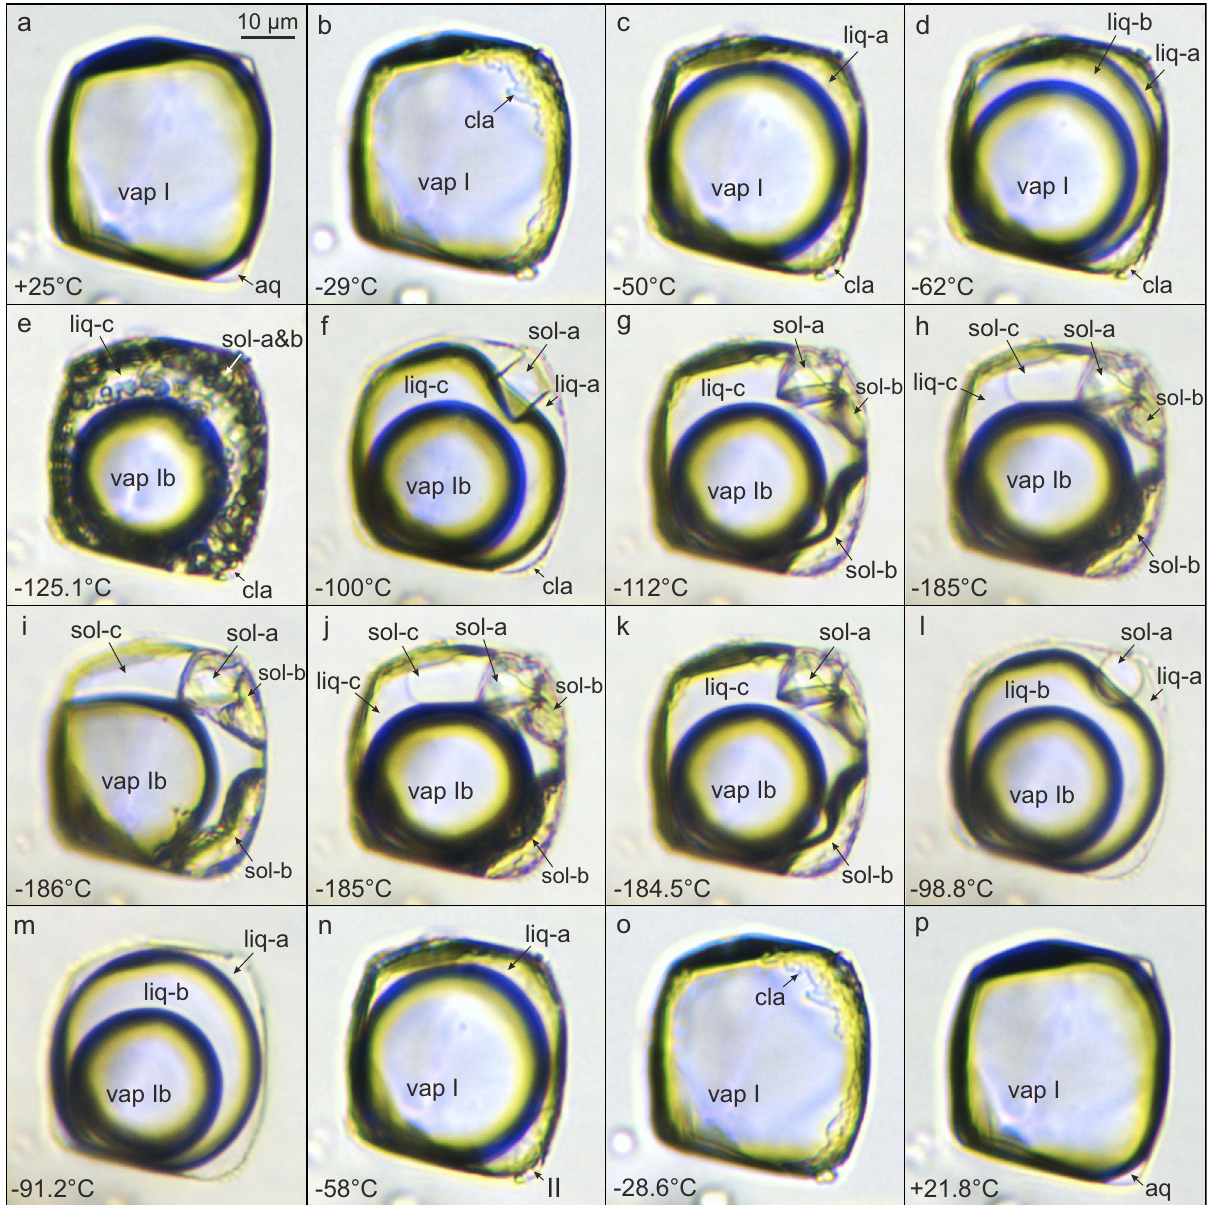
Fig. 2 Transmitted light microphotographs of phase transitions in CH 4 – H 2 S – CO 2 – N 2 – H 2 O fl uid inclusion (no. P1- fi 1A) during freezing and heating runs. a One-phase gas inclusion (vap I) at room temperature. b Clathrate (cla) formation as a result of the aqueous rim (aq) wetting the gas inclusion. c Exsolution of liquid H 2 S phase (liq-a). d Unmixing of liquid CH 4 -CO 2 phase (liq-b). e Instantaneous and simultaneous crystallization of liquid H 2 S and liquid CO 2 into a fi ne-grained ice mass. f Nucleation of an octahedral CO 2 crystal (sol-a) in the presence of liquid H 2 S (liq-a) produced by heating-freezing cycling run. g Nucleation of two “ blobby ” H 2 S solids (sol-b) in the presence of liquid CH 4 (liq-c), by applying cycling technique. h Continuous solidi fi cation of methane with visible solid/liquid methane (sol-c/liq-c) phase boundary. i Co-existence of three solid phases: CH 4 (sol-c), H 2 S (sol-b), CO 2 (sol-a) and CH 4 -N 2 gas phase (vap Ib). j , k Continuous liquefaction of solid CH 4 (sol-c) until completion at − 184.5°C. l Rounded CO 2 solid (sol-a) in the presence of liquid H 2 S (liq-a) after H 2 S solid melted at − 98.8 °C. m , n Post-CO 2 solid melting at − 91.2 °C, continuous vaporization of liquid CH 4 -CO 2 phase (liq-b), which is fi nalized by partial homogenization to a vapor phase (vap I). o Vaporization of liquid H 2 S (liq-a) fi nalized by total homogenization to a vapor phase (vap I) at − 28.6 °C. p Melting of clathrate (cla) at + 21.8 °C. Symbols and abbreviations: vap-gas phases: vap I: CH 4 – H 2 S – CO 2 – N 2 , vap Ib: CH 4 – N 2 ; cla- clathrate; liq-liquid phases: liq-a: H 2 S, liq-b: CH 4 – CO 2 , liq-c: CH 4 ; sol-solid phases: sol-a: CO 2 , sol-b: H 2 S, sol-c: CH 4 ; aq-aqueous and 7). The lower intensity fi ve peaks on the high-frequency side of optical microscope. The median temperature range for the H 2 S the Raman spectrum (Fig. 7) develop in an expense of the ( β → γ ) transition is between − 175.1 and − 176.1 °C, which gives an major H 2 S- β peak by decrease in its intensity (Fig. 6). These results overall median of − 175.6 °C and σ = 1.27 (Supplementary Table 2). are reproducible as H 2 S ( γ ↔ β ) transitions have been observed The transformation to H 2 S- γ in the studied inclusion is re fl ected by the appearance of six characteristic peaks at the following multiple times during real-time Raman spectroscopic analyses wavenumbers: 2523, 2541, 2545, 2547, 2552, and 2556 cm − 1 (Figs. 6 (Supplementary Table 2).